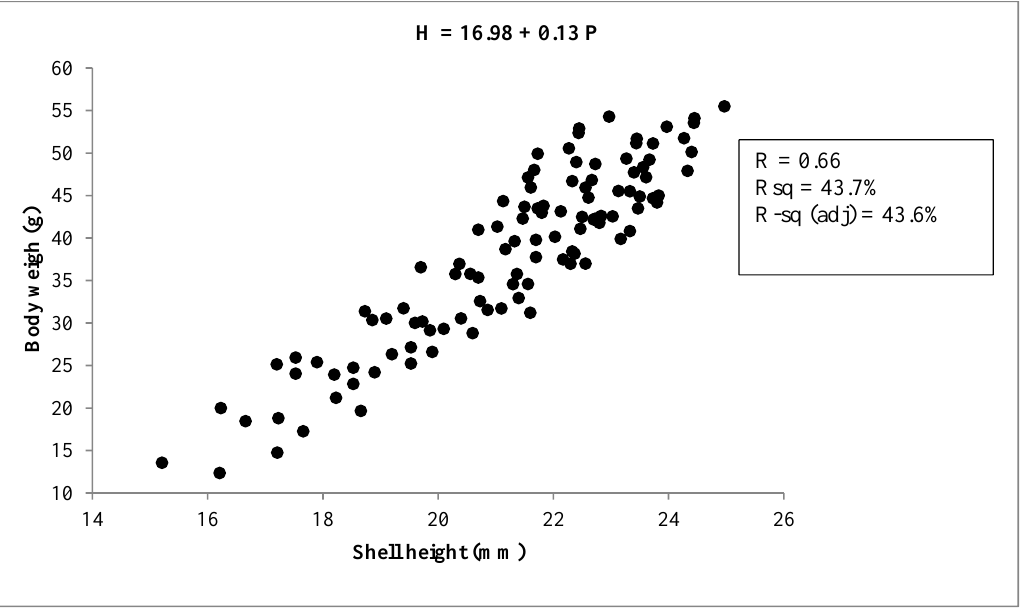
Figure 5. Morphological correlation for snout otter clams between body weight (BW) and shell height (SH), (all cultivation methods combined).